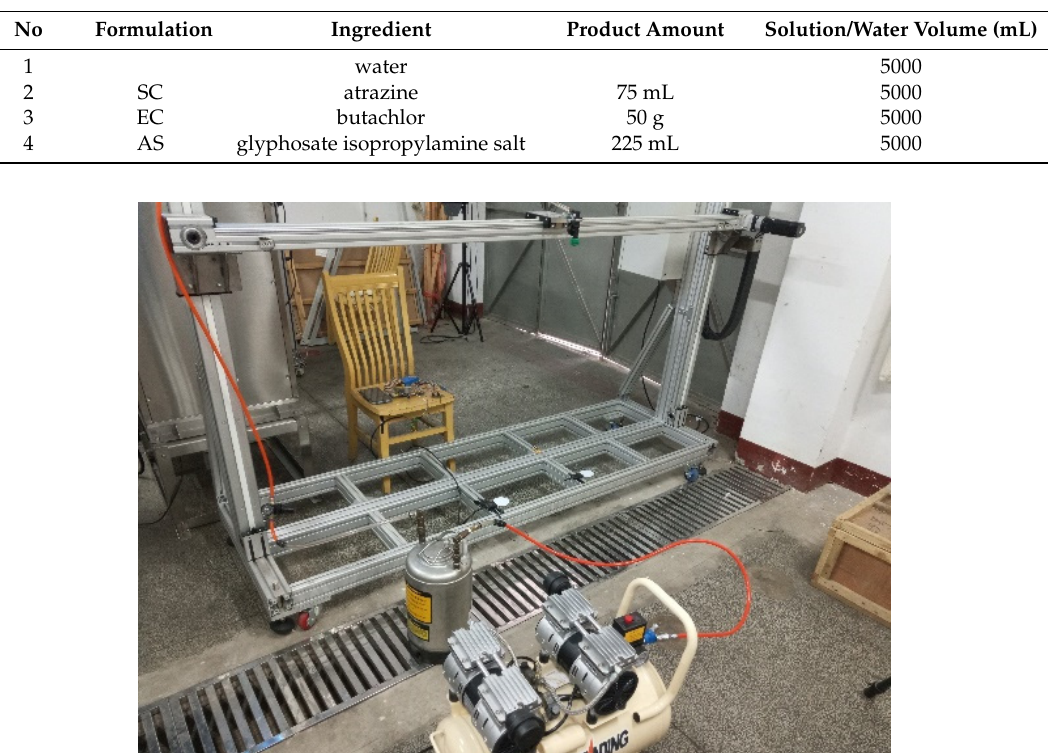
Table 1. Preparation of the sprays of the experiment